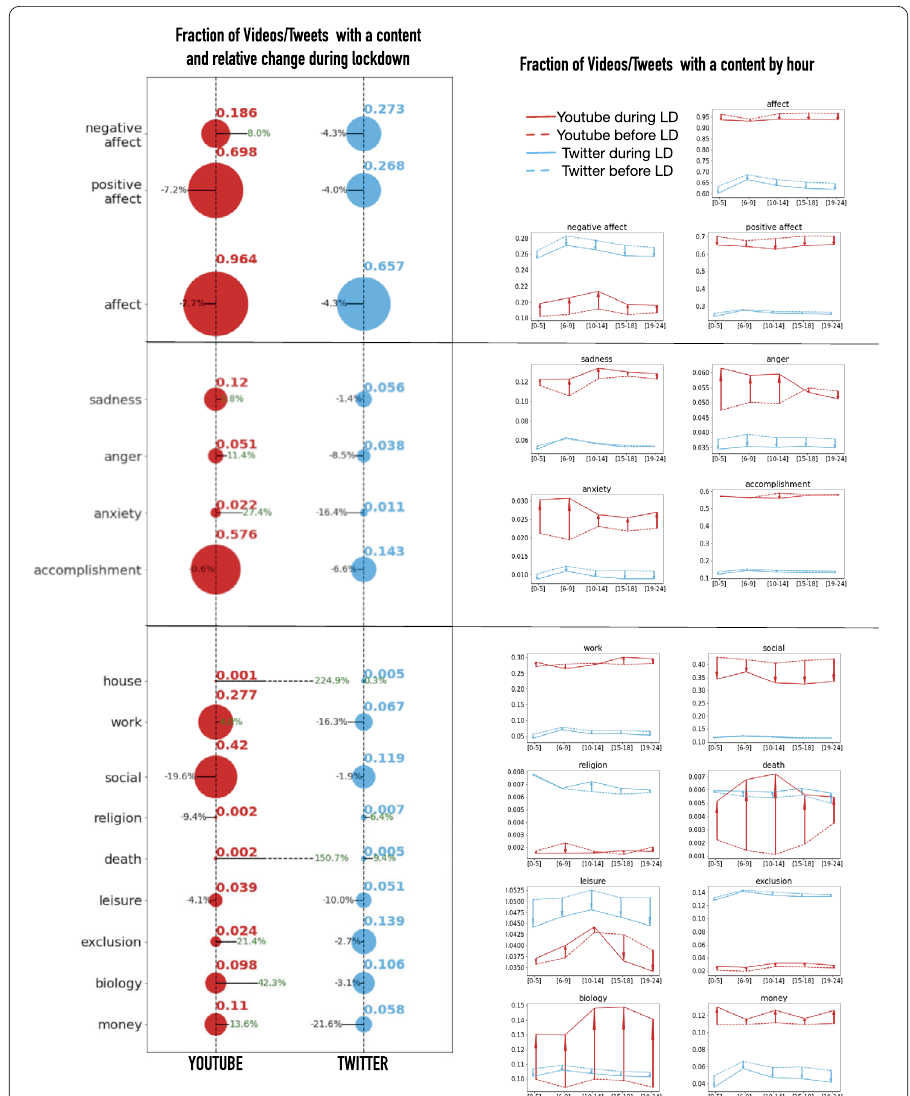
Figure 6 Themes and Emotions before and after lock-downs. Left plot: Fraction of videos/Tweets with a content and relative change with lockdown. The size of the points is proportional to the fractions (quantified by the upper numbers). The orientation of the line indicates if there was an increase (orientation toward right) or decrease (toward left) with the lockdown. The length of the line is proportional to the percentage increase/decrease with the lockdown. Right plot: Fraction of videos/Tweets with a content by hour. The continuous line indicates the fractions after the lockdown, the dotted lines before. An arrow starts from the before to the after line for each hour period: if the arrow is oriented towards the top, the lockdown increased the content fraction in the selected hours and viceversa. In both plots YouTube is in red, Twitter is in blue